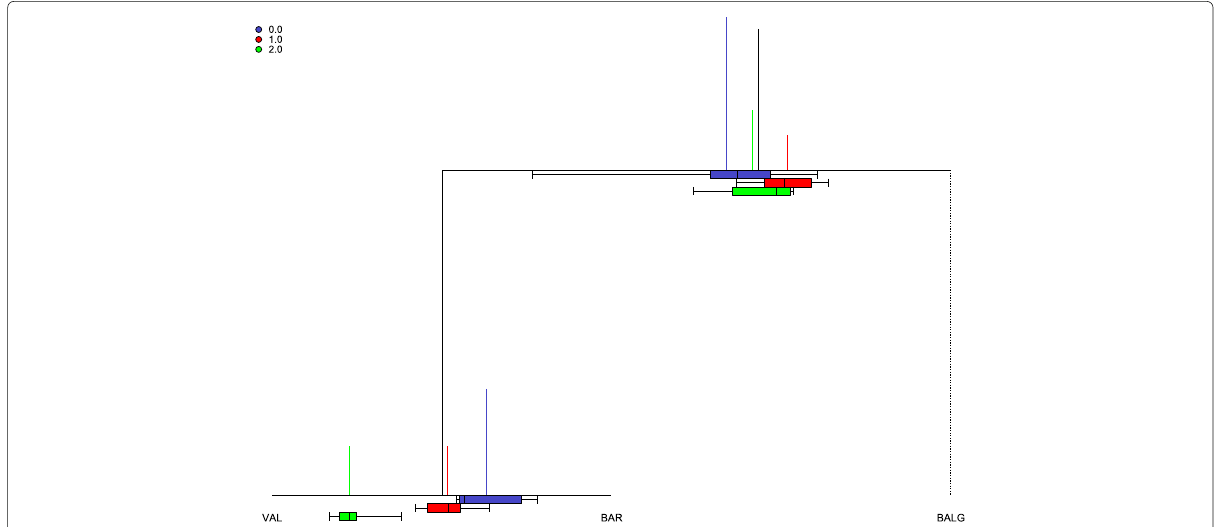
Fig. 6 Codadendrogram. Balances of BALG-BAR-VAL traffic composition following the selected SBP (Table 3). Color: Blue corresponds to the period 1976–1989 (before containerization boom), red corresponds to the period 1990–2007 (before the crisis) and green corresponds to the